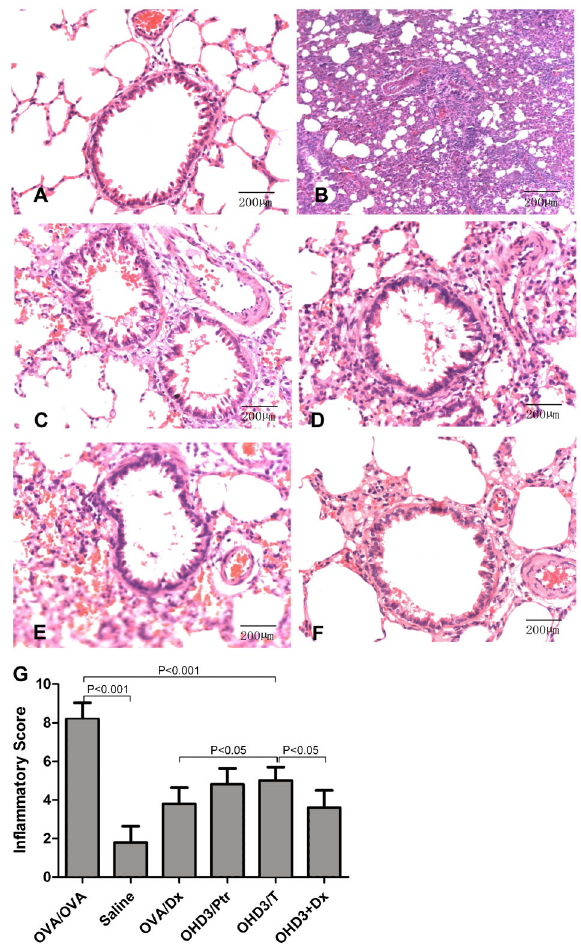
Figure 2. Representative images of paraffin-embedded and hematoxylin-eosin-stained sections of the right lobe of lungs from rats treated with saline ( A ), OVA/OVA ( B ), OVA/Dx ( C ), OHD3/ Ptr ( D ), OHD3/T ( E ), OHD3++Dx ( F ). G , Effect of different treatments on the inflammation score. Mann-Whitney U tests were used for statistical analyses. Saline: control group; OVA/ OVA: asthma group; OVA/Dx: dexamethasone treated group; OHD3/Ptr: 1,25(OH) 2 D 3 pretreatment group; OHD3/T: 1,25(OH) 2 D 3 treated group; OHD3++Dx: dexamethasone and (OH) 2 D 3 -treated group (P , 0.001). The combined treat-